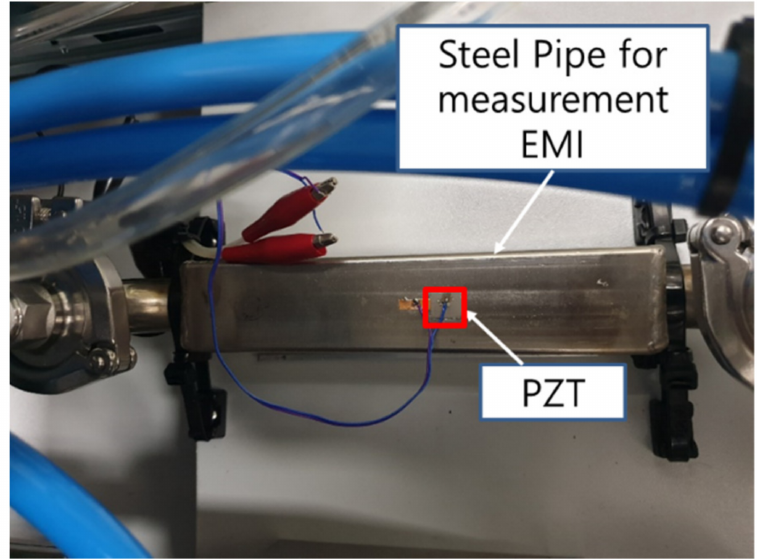
Figure 1. External steel pipe for measuring